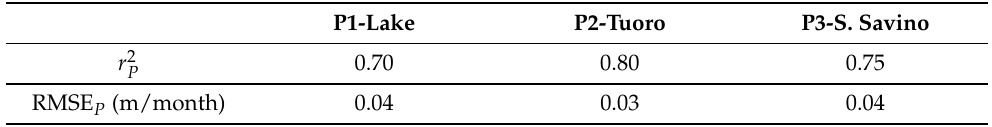
Table 2. Pearson correlation coefficient, r 2 period